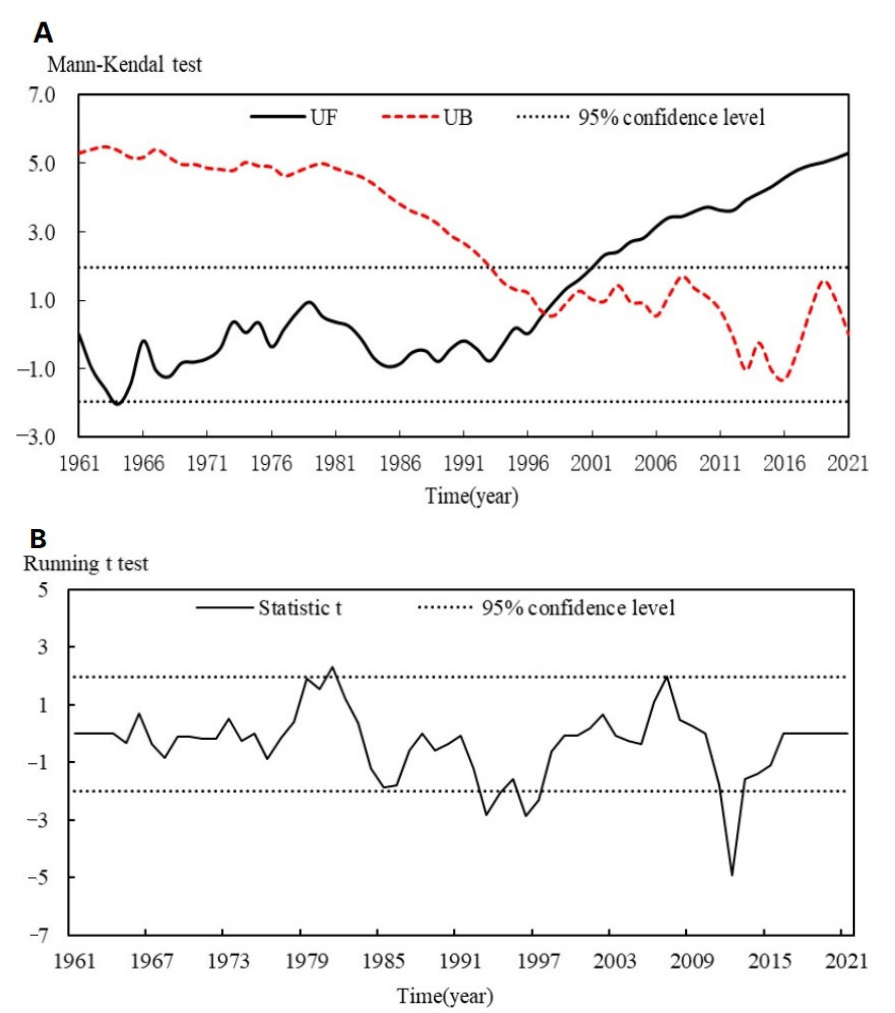
Figure 7. Mann–Kendall ( A ) and running t -tests ( B ) for the time series of the AMT over the QMs during the period from 1961 − 2021. The two black dashed lines indicate the 95% confidence level of the two tests. In ( A ), the black line denotes the sequential statistical curve, UF, and the red dashed line denotes the reverse statistical curve, UB. The black lines in ( B ) denote the sequential statistical curve